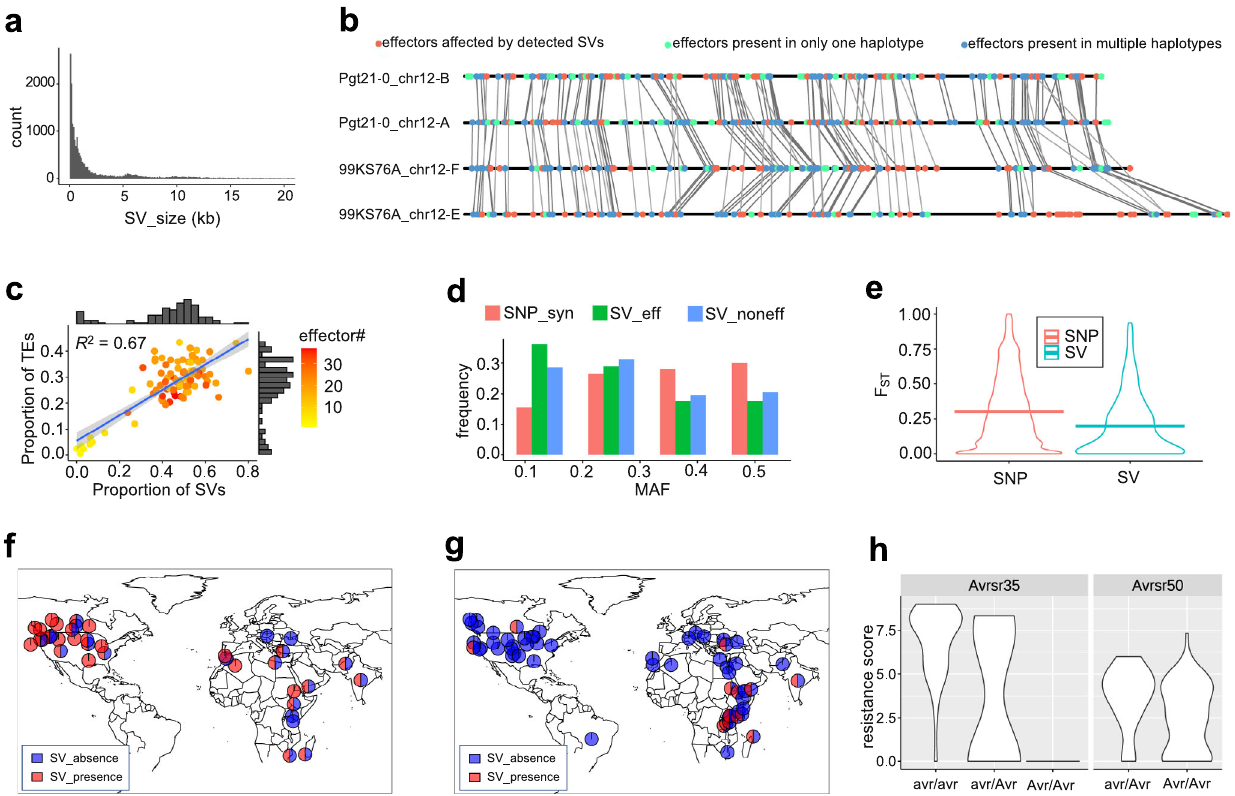
Fig. 4 | The SV size, SV distribution, and pairwise genetic differentiation at SV sites between the groups of Pgt isolates from different geographic regions. a SV size distribution. Outliers of SV size greater than 20kbp are not displayed. b The panel shows the synteny map of effector-encoding genes between the four homologous chromosomes from the 99KS76A-1 and Pgt21-0 isolates. Effectors affected by SVsare represented with coraldots, green dots show effectorsthatare present in only one haplotype, and blue dots show the remaining effectors. The effector-encodinggenescollinearbetweenthePgthaplotypesareconnectedusing gray lines. c Relationship between the TE content, structural variation, and pre- dicted effector content. The proportion of TEs and SVs within each non-